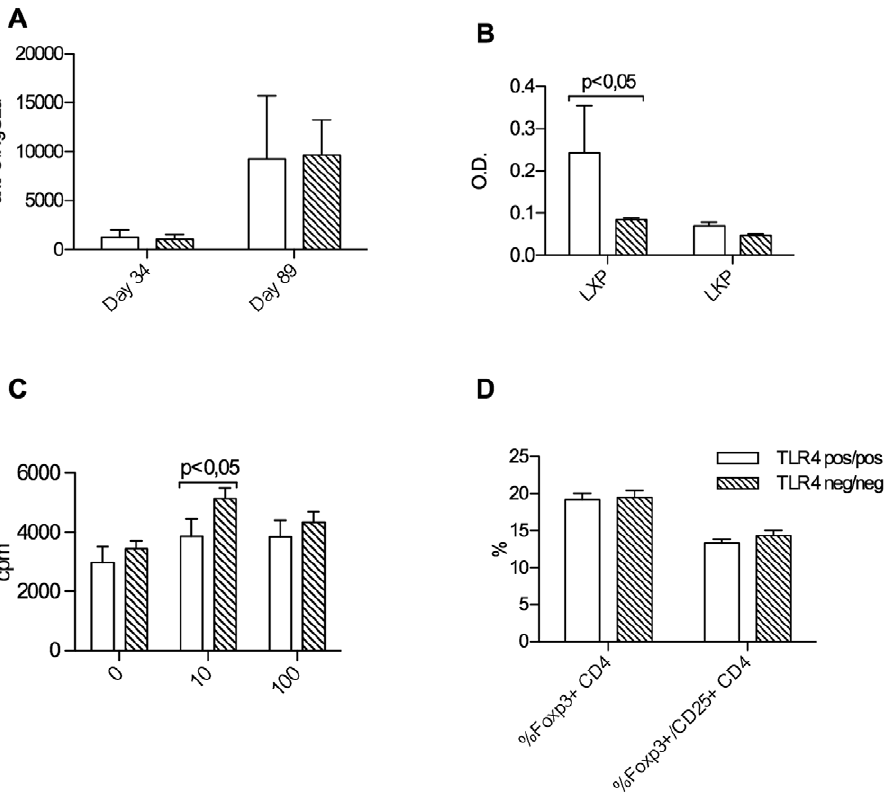
Figure 3. B and T cell responses. No significant difference in peripheral blood anti-collagen type II antibody concentrations of the IgG2a subclass at days 34 and 89 in TLR4 negative versus positive groups of mice (A). Anti-cyclic citrullinted peptide (CCP) antibody concentrations (anti-LXP) are significantly higher in TLR4 positive groups of mice at day 34 after immunization, while anti-non-citrullinated controle peptide antibody concentrations are comparable (B). T cell recall responses in TLR4 negative mice were significantly stronger than in wt mice at the lower tested antigen concentration (C). No influence on foxp3 positive Treg numbers was seen (D).